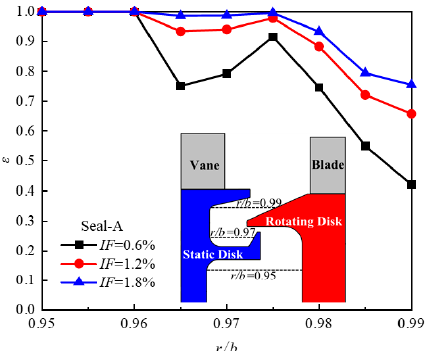
Figure 18. Sealing efficiency distribution along the disk cavity radial direction.